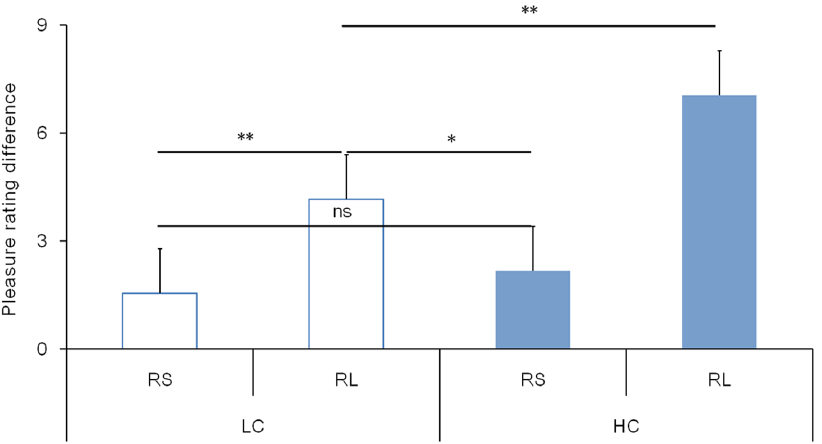
Figure 2 . Difference in subjective rating of p leasure between losses and wins for results of different magnitudes . Error bars represent standard error (SE). RS, relatively small; RL, relatively large; LC, low amount context; HC, high amount context; *, significant difference of p , .05; **, significant difference of p , .005; ns, non-significant.